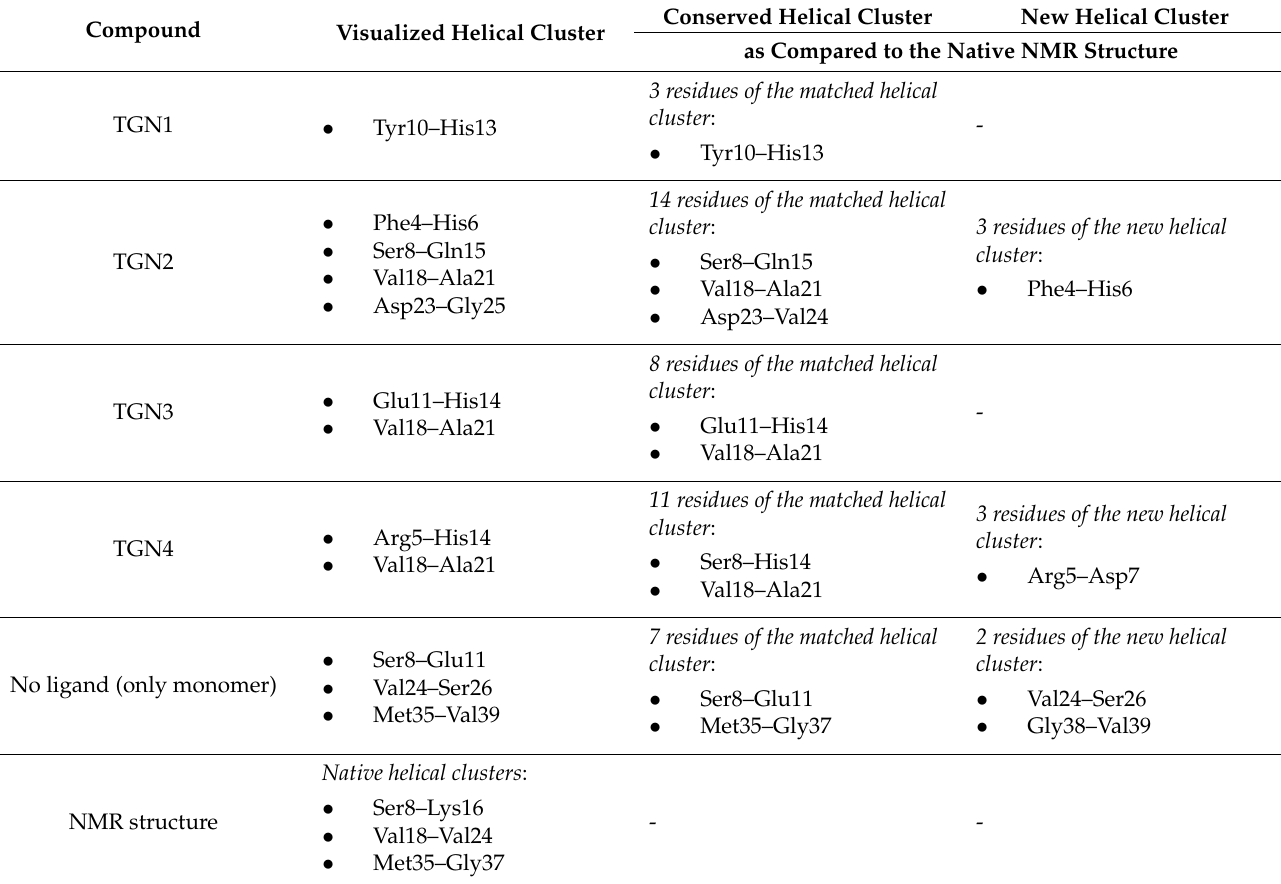
Table 4. The conserved and new helical clusters of the A β 1–42 monomers from all models. Conserved Helical Cluster New Helical Cluster Compound Visualized Helical Cluster as Compared to the Native NMR